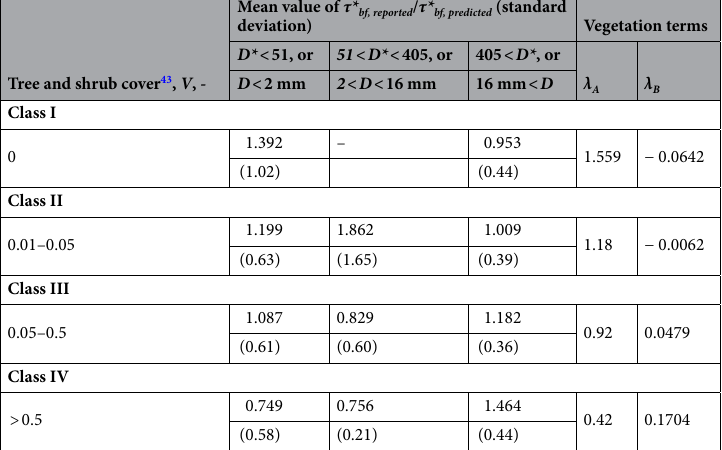
Table 1. Average correction coefficients for each of four woody vegetation